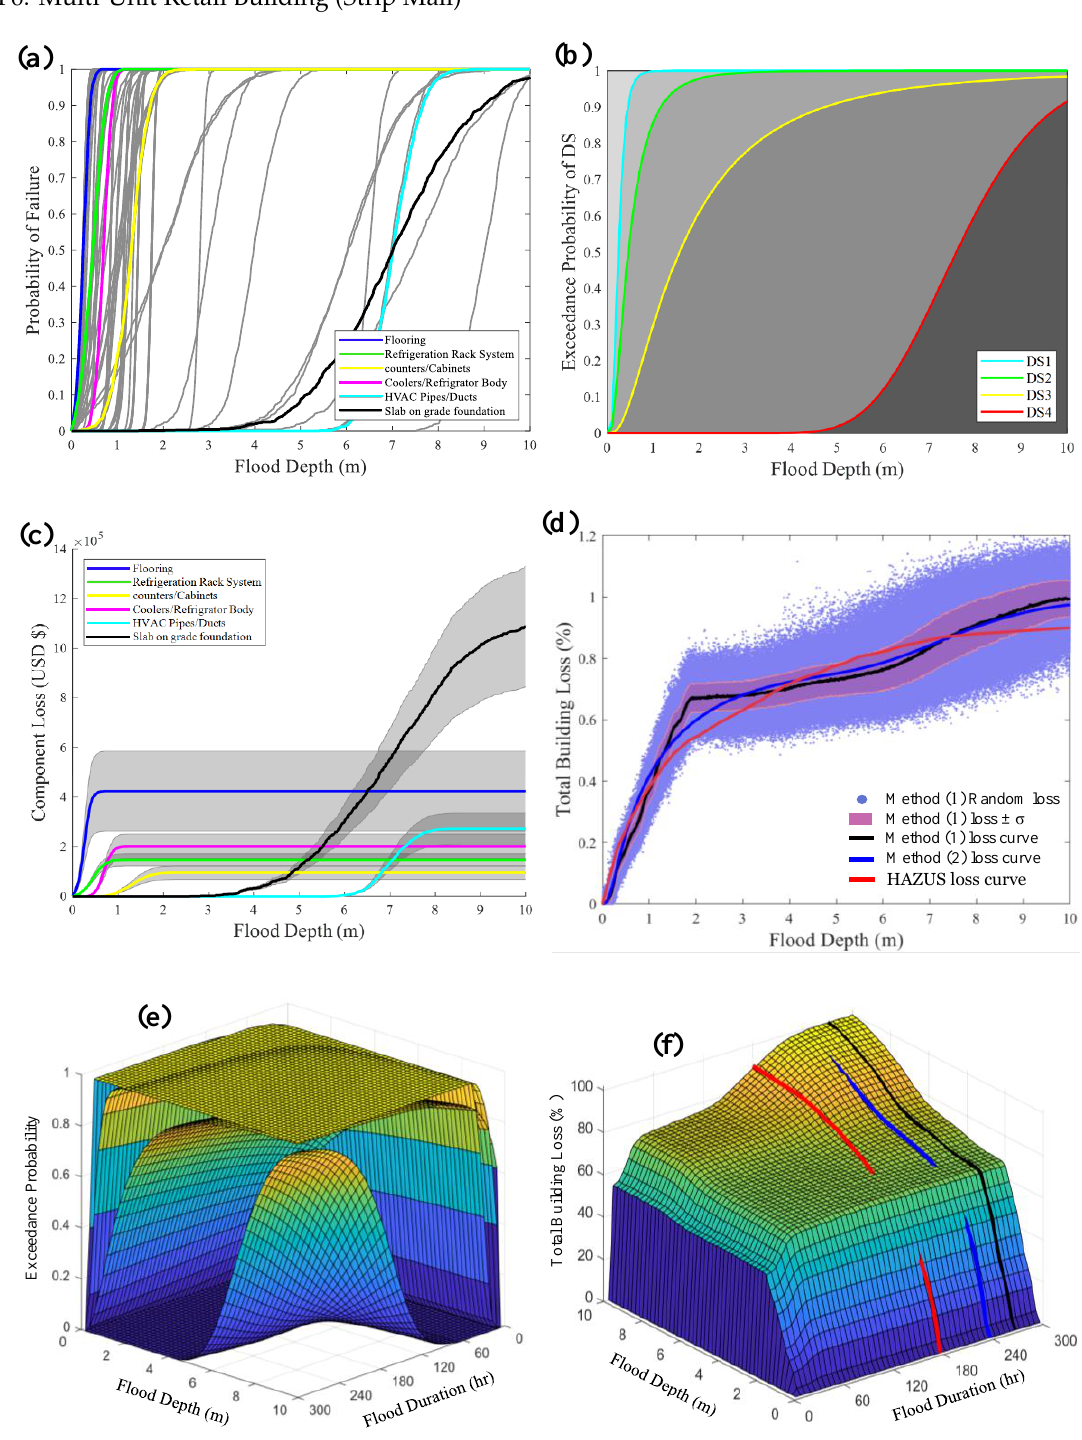
Figure A20. F6 archetype analysis results: ( a ) Component fragility curves; ( b ) Building fragility curves; ( c ) Selected components’ loss curves; ( d ) Building loss curves; ( e ) Building fragility surfaces; ( f ) Building loss surface.